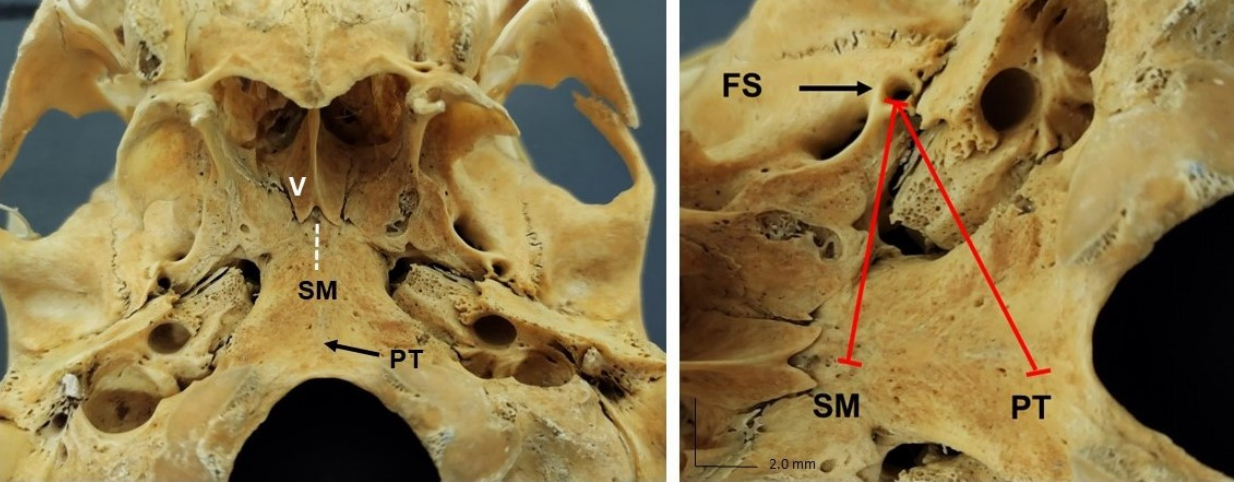
Figure 3. Inferior view of the skull showing the distance from the foramen spinosum (FS) to the midpoint of the skull base (SM) and the pharyngeal tubercle (PT). V: vomer bone. The FS was measured at the transverse plane from an inferior view of the skull base as a 2D image using a digital microscope (Dino-Lite ® ). The relevant data included the shape, size, and number of the FS, so there was no need to study the FS in other planes, such as frontal or sagittal.